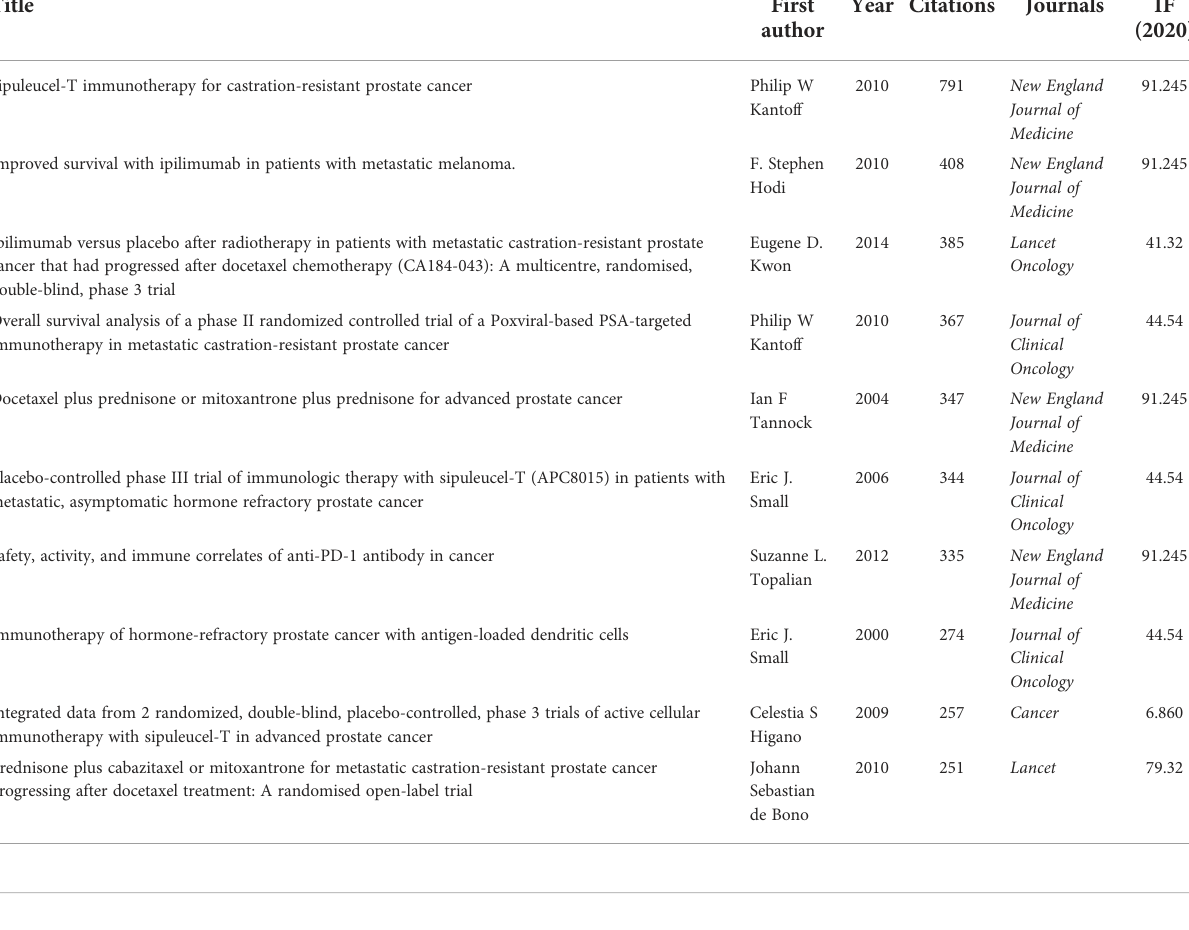
TABLE 4 Top 10 co-cited references involved in the research of PCa